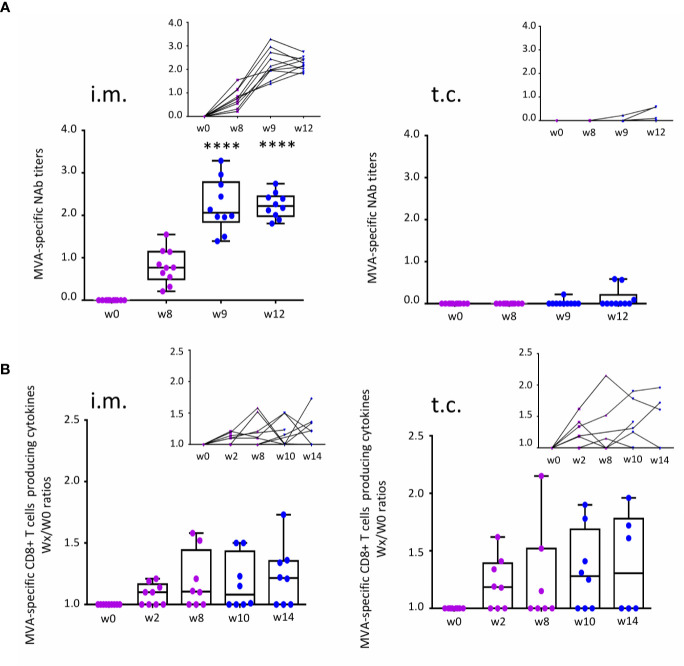
Measurement of immune responses to MVA-B vaccine after t.c. and i.m. vaccination. (A) MVA-specific neutralizing antibody (NAb) response before (w0) and after the prime (purple, w8) and boost (blue, w9 and w12) vaccinations for each administration route: i.m. (n = 10) and t.c. (n = 10). Data analysis presents neutralizing antibody titers (log 1/EC50) in box-and-whisker plots with the minimum to maximum showing all points (from the bottom up: the minimum 25th percentile Q1, median, 75th percentile Q3, and maximum values) and in line charts. (B) MVA-specific CD8+ T cells expressing intracellular cytokines IFNγ, MIP-1β, IL-2, and TNFα before (w0) and after prime (w2 and w8) and after the boost (w10 and w14) vaccinations for each administration route: i.m. (w0 and w2, n = 9; w8, w10, and w14, n = 8) and t.c. (w0, w2, and w10, n = 8; w8, n = 7; w14, n = 6). Data analysis presents the ratios wx/w0 of the percentages of MVA-specific CD8+ T cells (Boolean IFNγ, MIP-1β, IL-2, and/or TNFα). ANOVA Friedman test was applied (****p < 0.0001).